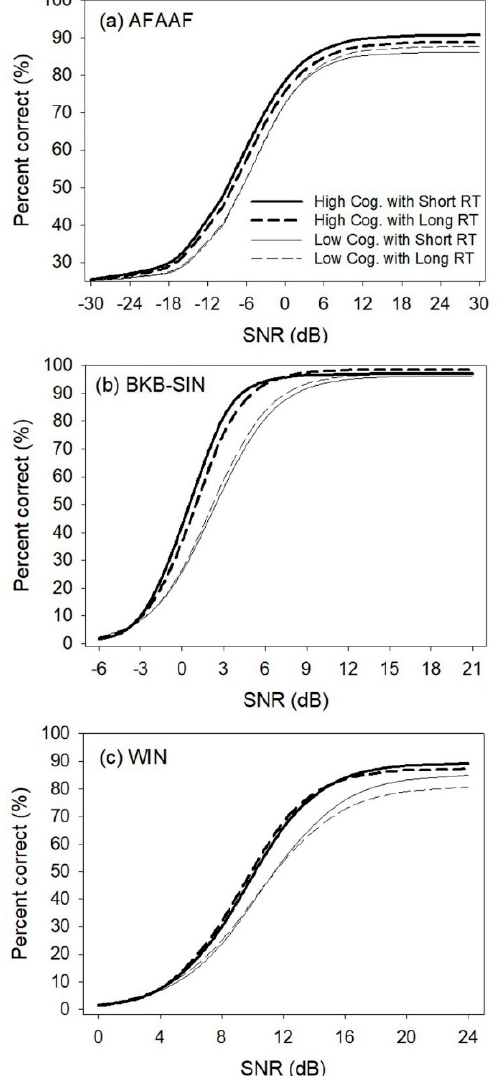
Figure A1. Psychometric functions were fitted to the mean percent correct scores for each cognitive group and each speech recognition test with both RTs using Equations (1) and (2) for displaying performance patterns. The slopes for high and low cognitive groups are 13%/dB and 8%/dB for the BKB-SIN test and 10%/dB and 7%/dB for the WIN test, respectively. With the AFAAF test, slopes for both cognitive groups are about 3%/dB. Tested SNRs were from -9 to +12 dB for the AFAAF test.